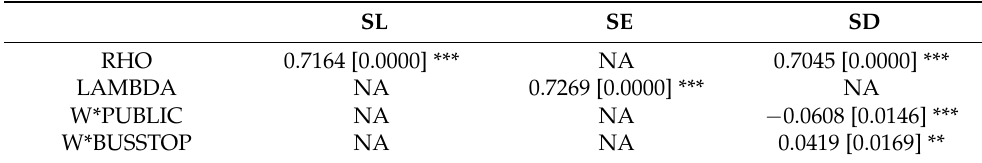
Table A2. Estimates of the spatial autocorrelation parameters for spatial-PD-STIRPAT models.